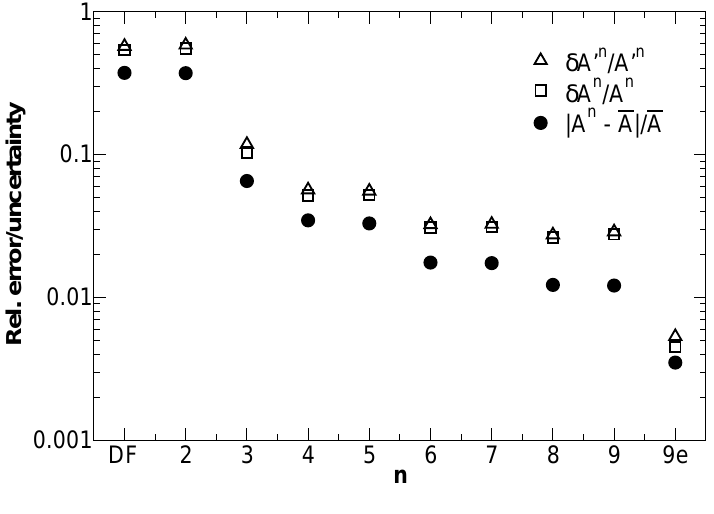
Figure 3. Relative error (solid dots) compared with uncertainty estimates (open symbols) against active orbital set expansion in calculations. DF and 9e stands for Dirac-Fock and n = 9 with an extended multireference, respectively. See text for